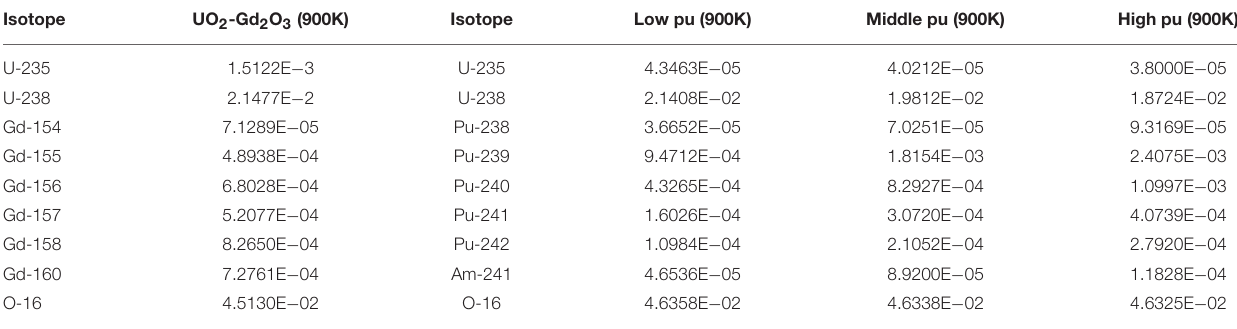
TABLE 5 | Number densities of nuclides of UO2 and MOX assembly (barn/cm).